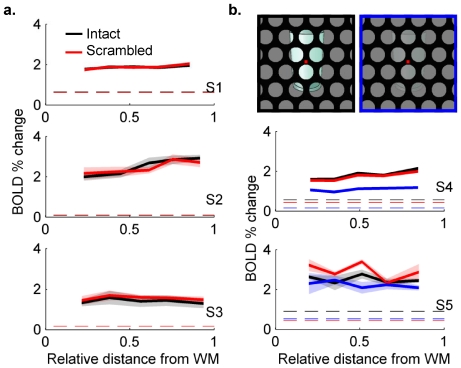
Laminar profiles of BOLD responses for significantly modulated voxels in V1.a.) Solid lines represent mean across repeated scans, shading indicates standard error across scans. Dashed lines represent average fMRI response in WM voxels. Significance threshold for defining activated voxels was adjusted for each subject to ensure a minimum of 300 voxels were included in the profile. S1: 1014/3287 voxels in V1 had p<0.001 (estimated by permutation analysis), 7 scans were averaged per condition; S2: 332/2036 V1 voxels with p<0.01, 5 scans per condition; S3: 325/1429 voxels in V1 with p<0.05, 5 scans per condition. b.) The control experiment included a set of scans in which the contrast of the intact objects reduced (image on top, right; blue laminar profiles). S4: 825/2953 of V1 voxels with p<0.001, 7 scans per condition; S5: 317/2126 of V1 voxels with p<0.05, 4 scans per condition.